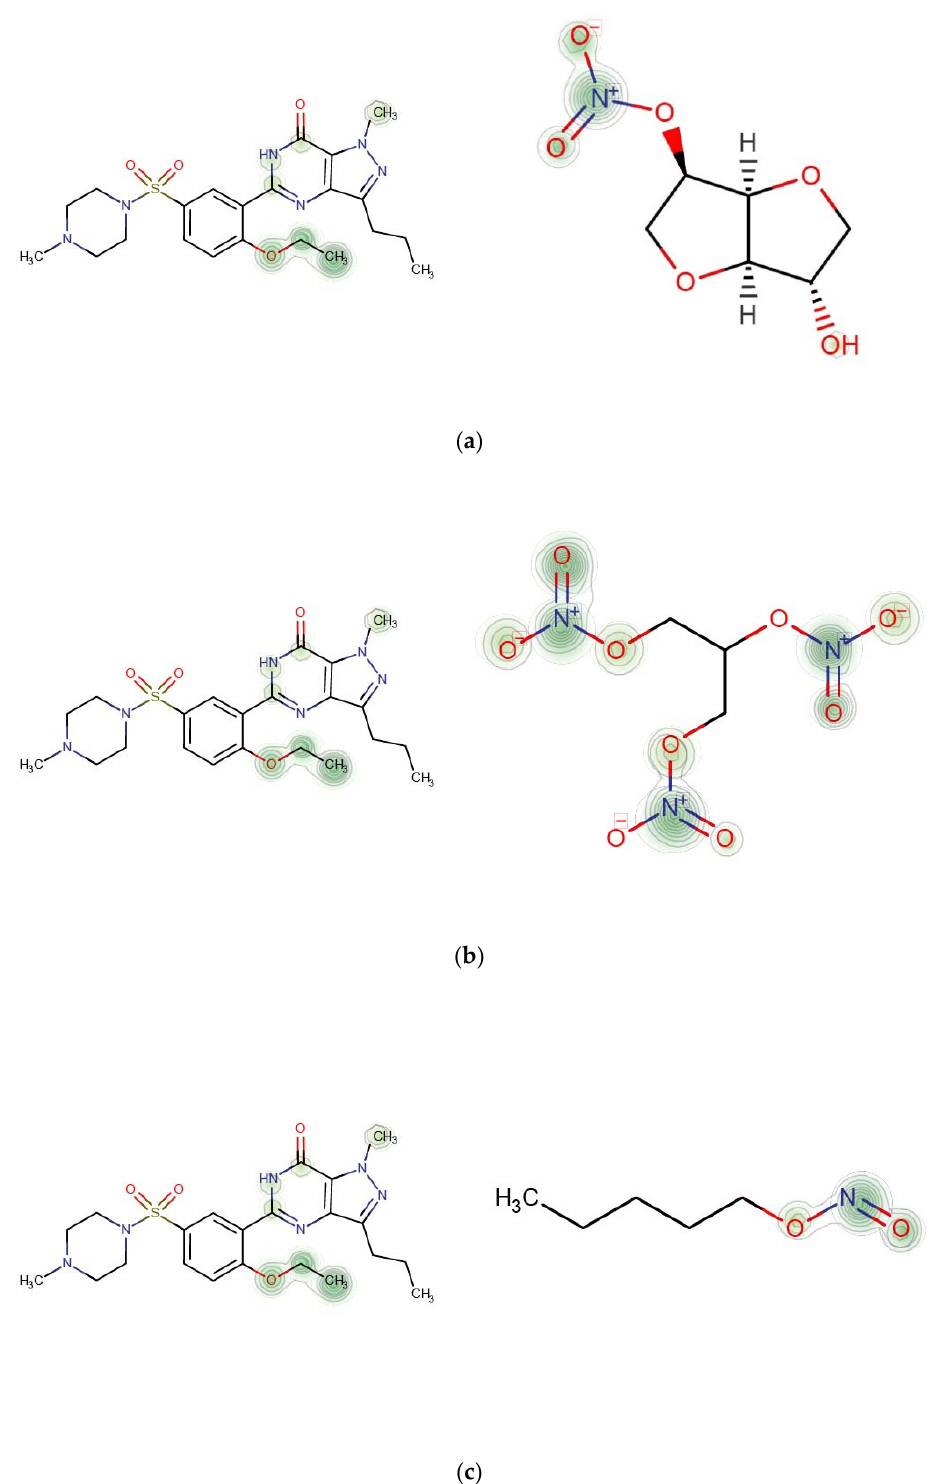
Figure 7. Contributions of specific substructures to drug interactions. ( a ) Sildenafil (k = 4) and Isosorbide Mononitrate (k = 3). Description in DrugBank: The risk or severity of hypotension can be increased when Isosorbide mononitrate is combined with Sildenafil. ( b ) Sildenafil (k = 4) and Nitroglycerin (k = 3). Description in DrugBank: The risk or severity of hypotension can be increased when Nitroglycerin is combined with Sildenafil. ( c ) Sildenafil (k = 4) and Amyl Nitrite (k = 3). Description in DrugBank: The risk or severity of hypotension can be increased when Amyl Nitrite is combined with